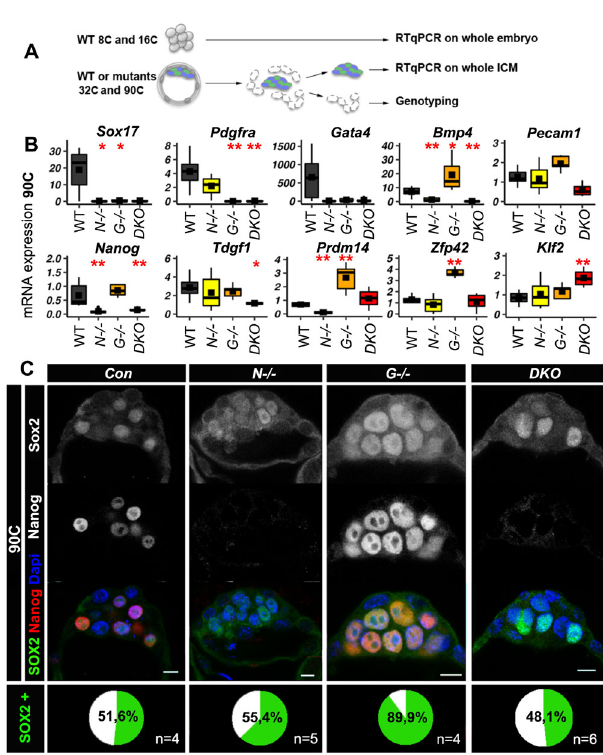
Fig. 2 Absence of PrE and Epi differentiation in DKO embryos. A Schematic representation of the experimental procedure used in ( B ) and Supplementary data 6. For the 8C and 16C stages, individual whole embryos were analysed, whereas for the 32C and 90C stages individual whole ICMs were isolated by immunosurgery. B PrE and Epi gene expression analysis by RT-qPCR. Boxplots show the relative RNA levels in 90C WT ( n = 6), Nanog − / − ( n = 6), Gata6 − / − ( n = 5), and DKO ( n = 6) whole ICMs. The mean is represented by a square, the median by the central line; * p < 0.05, ** p < 0.01 (Two-sided Wilcoxon test relative to the WT sample, see Supplementary data 15 for exact p values). The edges of the box represent the 25th and 75th quartiles. The whiskers extend to 1.5 times the interquartile range (25th to 75th percentile). Source data are provided in the Source Data fi le. C Representative immuno fl uorescence confocal images of NANOG and SOX2 localization in 90C Nanog − / − ( N ), Gata6 − / − ( G ), DKO , and control ( Con ) embryos. The percentage of SOX2- positive cells (SOX2 + ) in ICM is indicated in the bottom panel. Scale bars: 10 µ